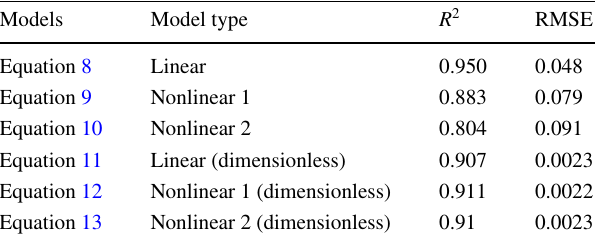
Table 2 Linear and nonlinear regression results for pressure head ( P or P t / P 0